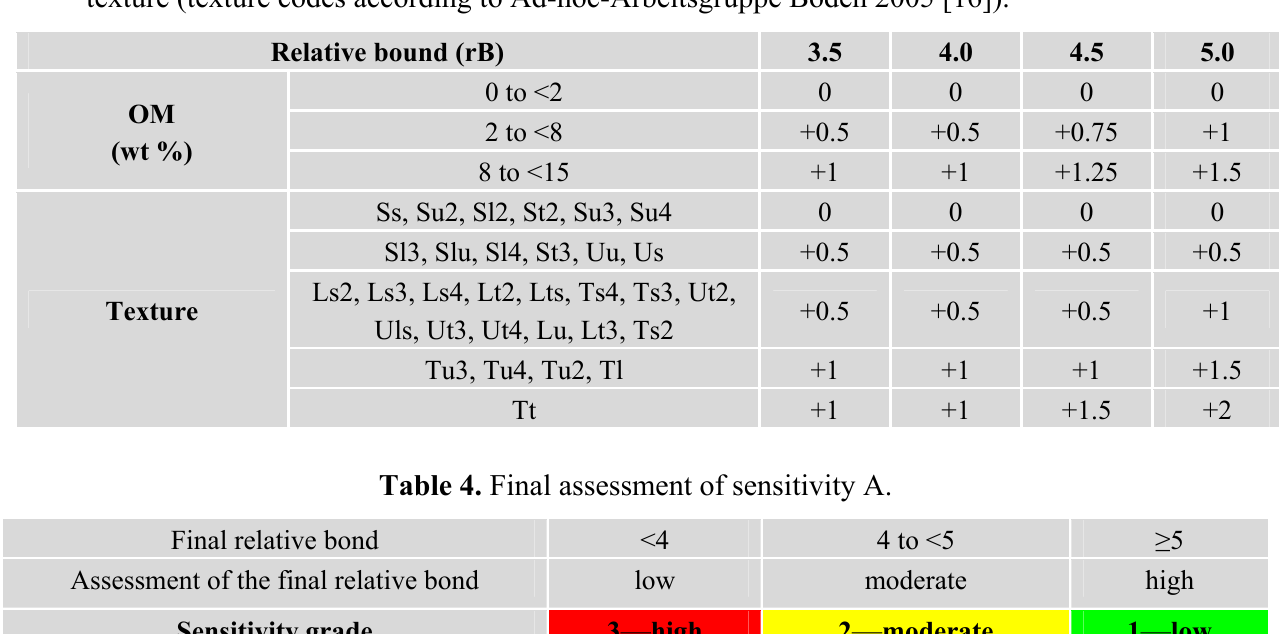
Table 3. Mark-up of the relative bond of cadmium in relation to OM content and soil texture (texture codes according to Ad-hoc-Arbeitsgruppe Boden 2005 [16]).